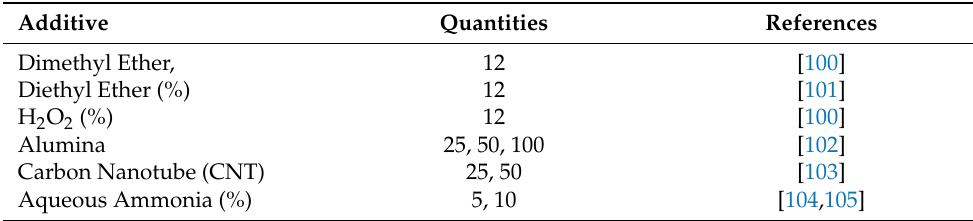
Table 4. Numerous emulsion preparation additives and their